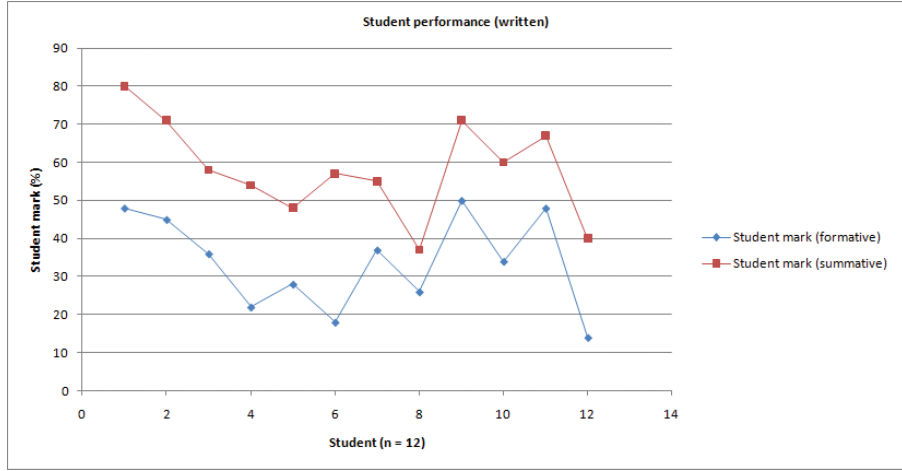
Figure 2. Student performance in formative and summative assessment (written).